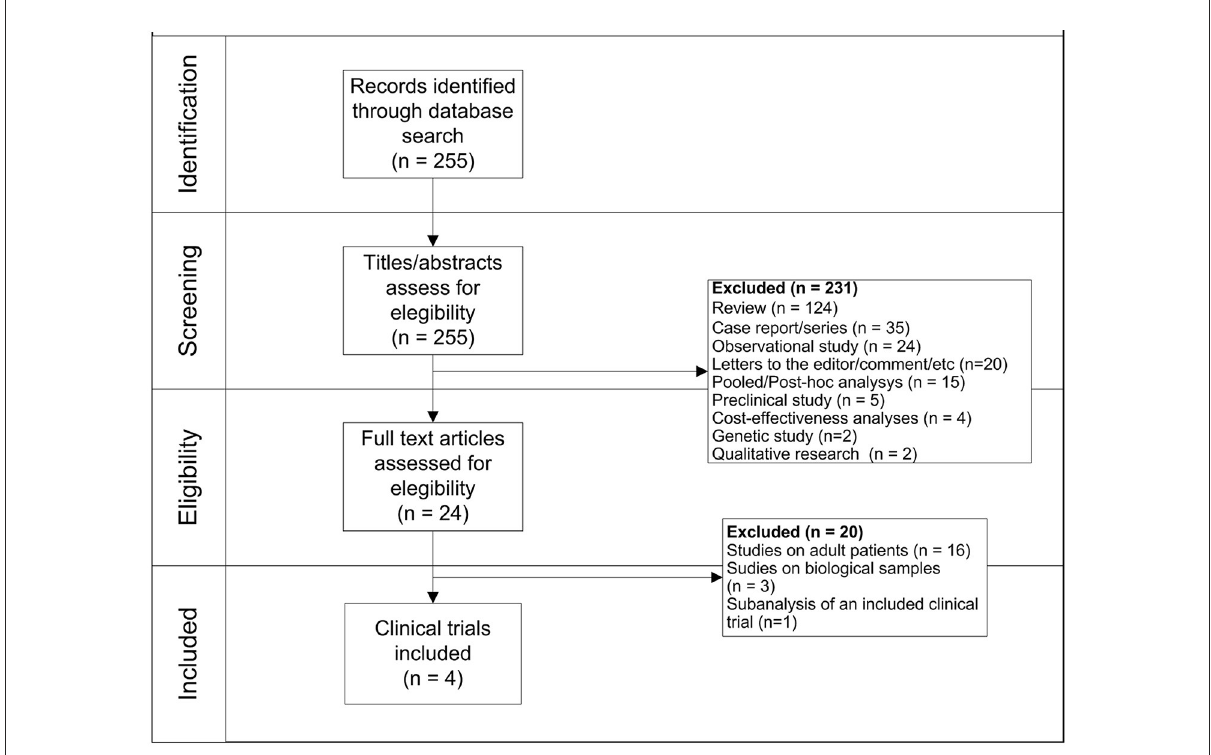
FIGURE1 Flow-chart for the identification of eligible clinical